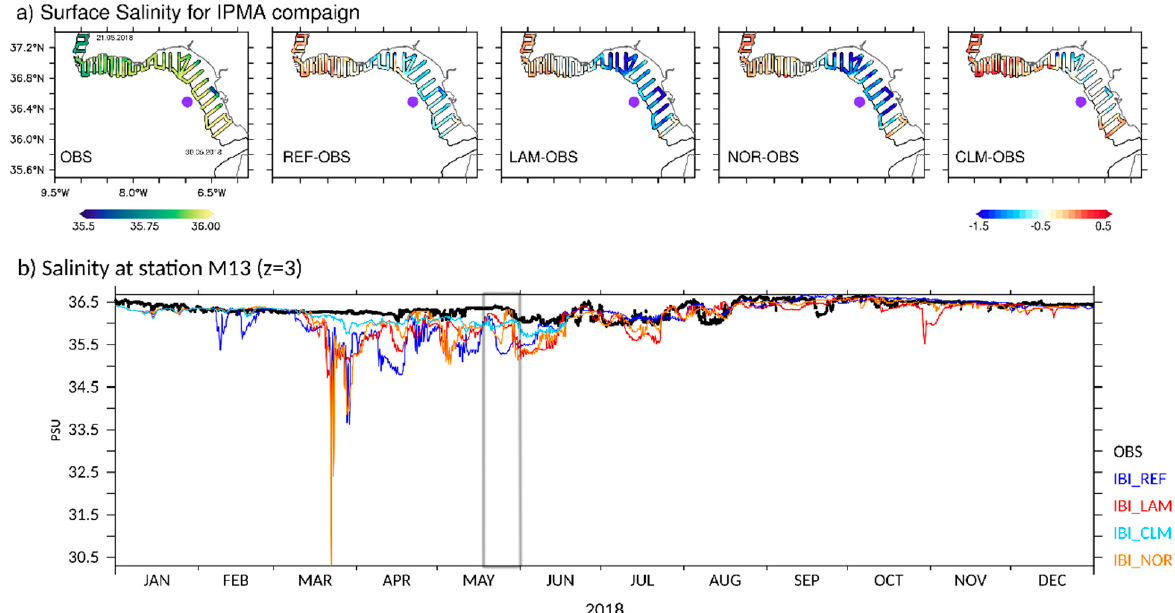
Figure 12. ( a ) Surface salinity during the IPMA campaign in late May 2018 in the CADIZ area. The left panel shows the observed salinity measured (by means of a thermo-salinometer), and the other panels (from left to right) show differences between modelled salinities (from IBI_REF, IBI_LAM, IBI_NOR, IBI_CLM model scenarios) and the observations. The purple dot depicts the location of the mooring buoy M13. ( b ) Timeseries of salinity at station M13, at the shelf-break of the Gulf of Cadiz. Observed salinity is represented by black dots and the different IBI model scenarios by solid lines (IBI_REF in blue, IBI_CLM in light blue, IBI_LAM in red and IBI_NOR in orange color). The grey rectangle highlights the period of the IPMA campaign in the Gulf of Cadiz. Table 7. Mean difference (Bias) and Root Mean Squared Error (RMSE) between observed salinity (from the M13 mooring buoy and the IPMA campaign) and simulated one (from the IBI_REF, IBI_LAM, IBI_CLM, IBI_NOR model scenarios), over the respective length of the simulations, in the CADIZ area. The smallest model bias and RMSE for each dataset are in bold. The mooring data have hourly frequency and IPMA data was measured every 10 min. N is the number of measurements. Salinity Observations in CADIZ RMSE Bias (Model Observations) IBI_REF IBI_LAM IBI_CLM *